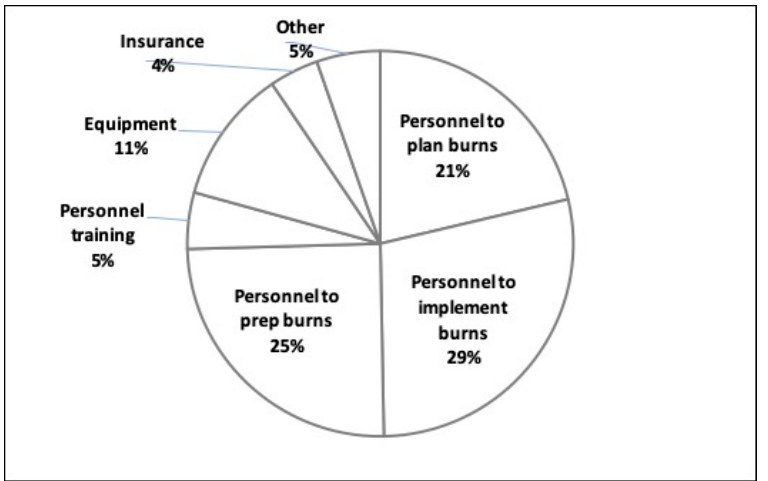
Figure 3. Highest Priority Budget Items to Increase Financial Resources for Prescribed Fire Expansion. Fire managers were asked to rank the top three budget items to increase financial allocations to expand prescribed burn area. Their responses were not weighted and were totaled. Other items included National Environmental Policy Act specialists, public education, and specific equipment needs (e.g., vehicles).